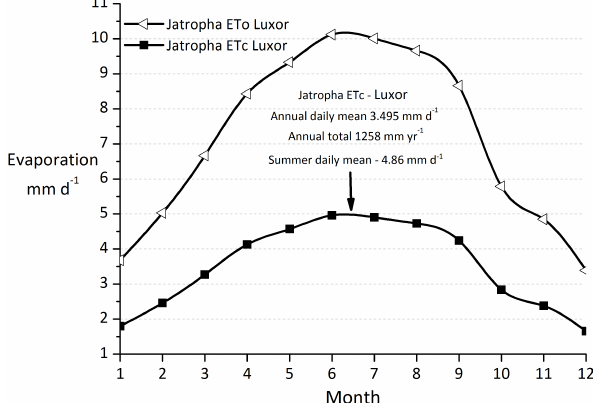
Fig. 10. ET 0 and ET C values obtained for a jatropha plantation in Luxor as reported in the USAID report Irrigation and Crop Man- agement Plan . The ET C is calculated using the Penman–Monteith FAO 56 method and a crop coefficient K C of 0.7 for jatropha. The annual total is calculated as 1258.61mmyr − 1